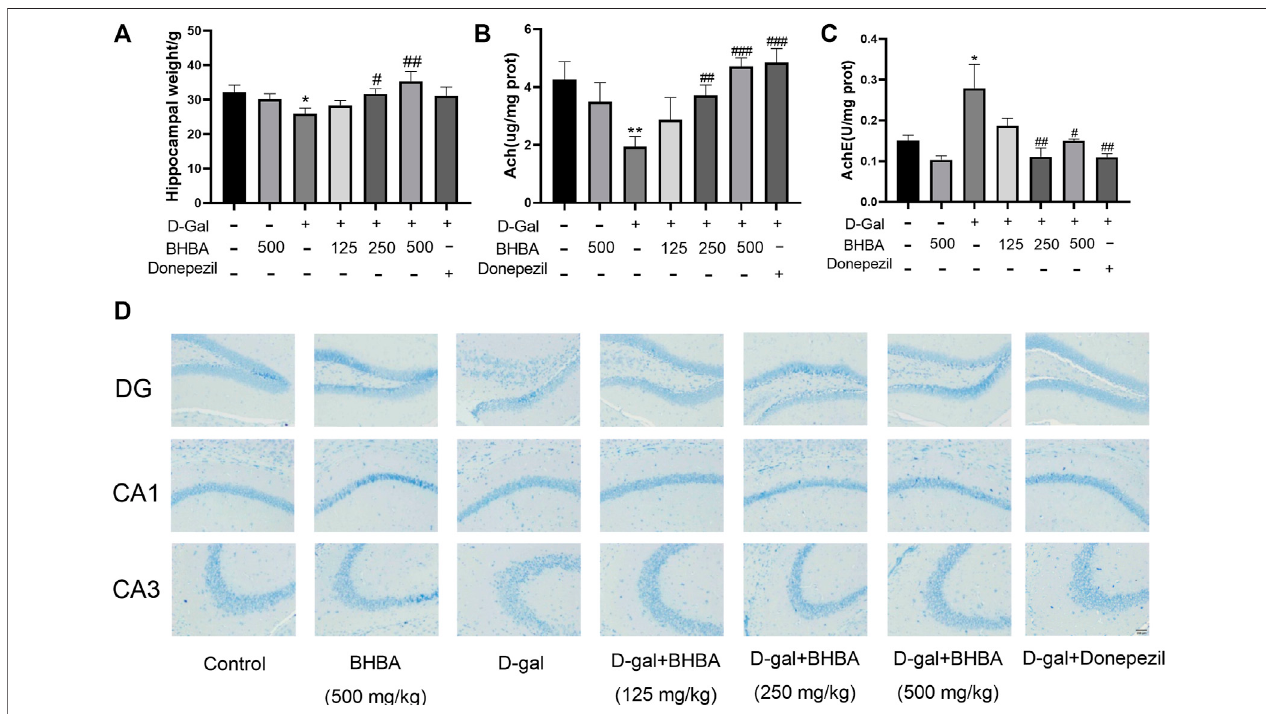
FIGURE 2 | Effects of BHBA on hippocampal damage, ACh, and AChE in D-gal-induced mice. (A) Hippocampal weight. (B) Content of ACh. (C) Activity of AChE. (D) Hippocampal morphology with Nissl staining (magni fi cation: 200X). D-gal: 180 mg/kg; BHBA: 125, 250, and 500 mg/kg, respectively; donepezil: 3 mg/kg, n (cid:1) 8. Compared with the control group, * p < 0.05, ** p < 0.01; compared with the D-gal group, # p < 0.05, ## p < 0.01, ### p <